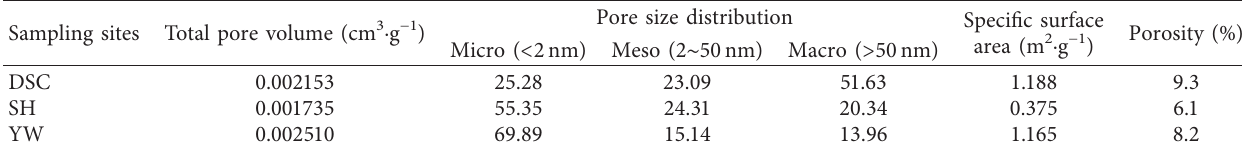
Table 2: Microscopic parameters of coal